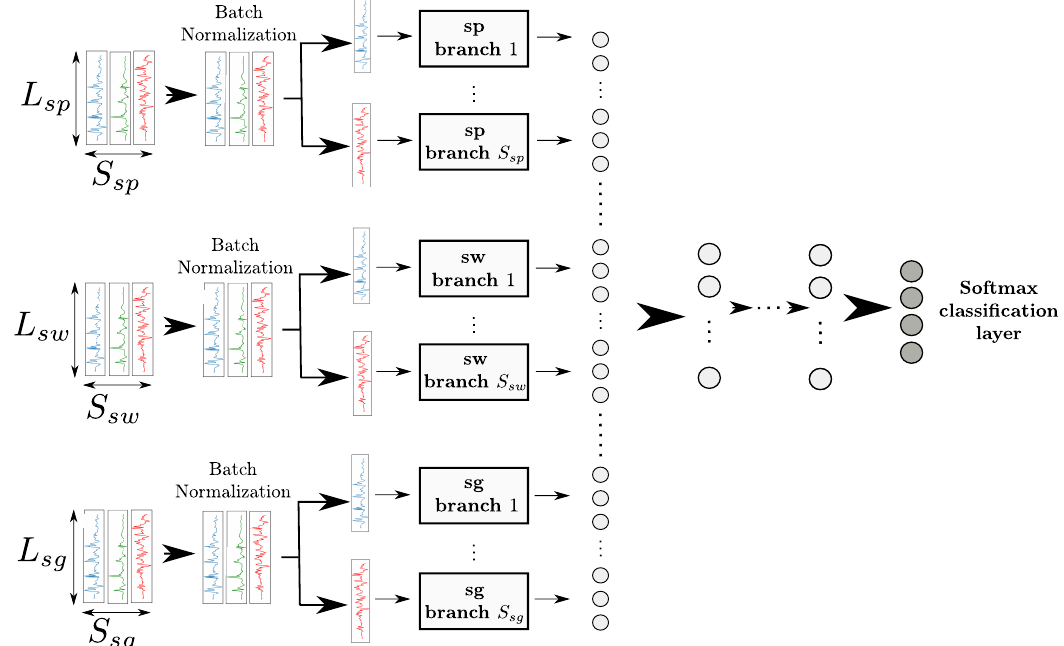
Figure 3. Model used on the CogAge dataset. Each of the three mDNNs processes the smartphone (sp), smartwatch (sw) or smartglasses (sg) data. L ∗ and S ∗ with ∗ ∈ { sp , sw , sg } refer to the segment length and number of sensor channels, respectively. Outputs from the three mDNNs are concatenated and fed into fully-connected and softmax